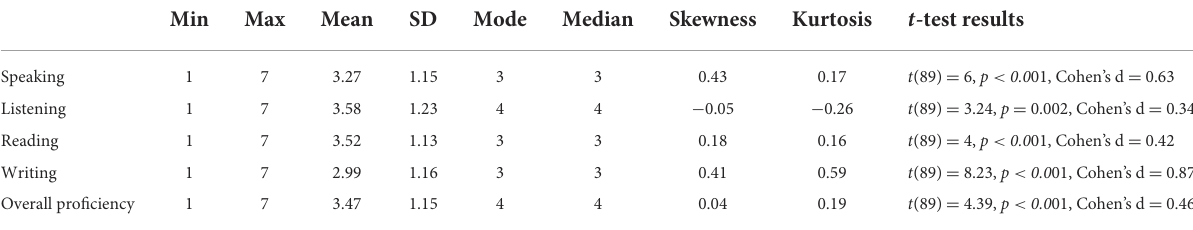
TABLE 2 Summary of the participants’ self-rated Chinese language